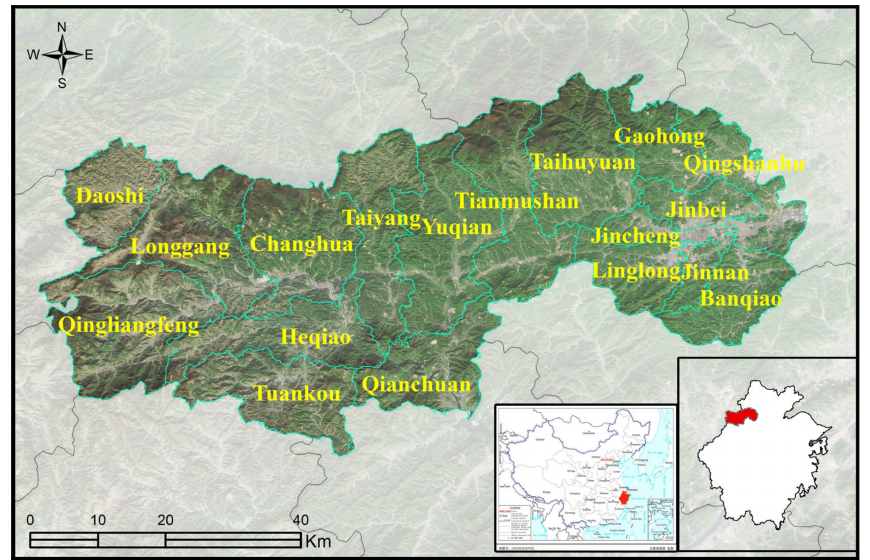
Figure 1. Geographic location of the study area.